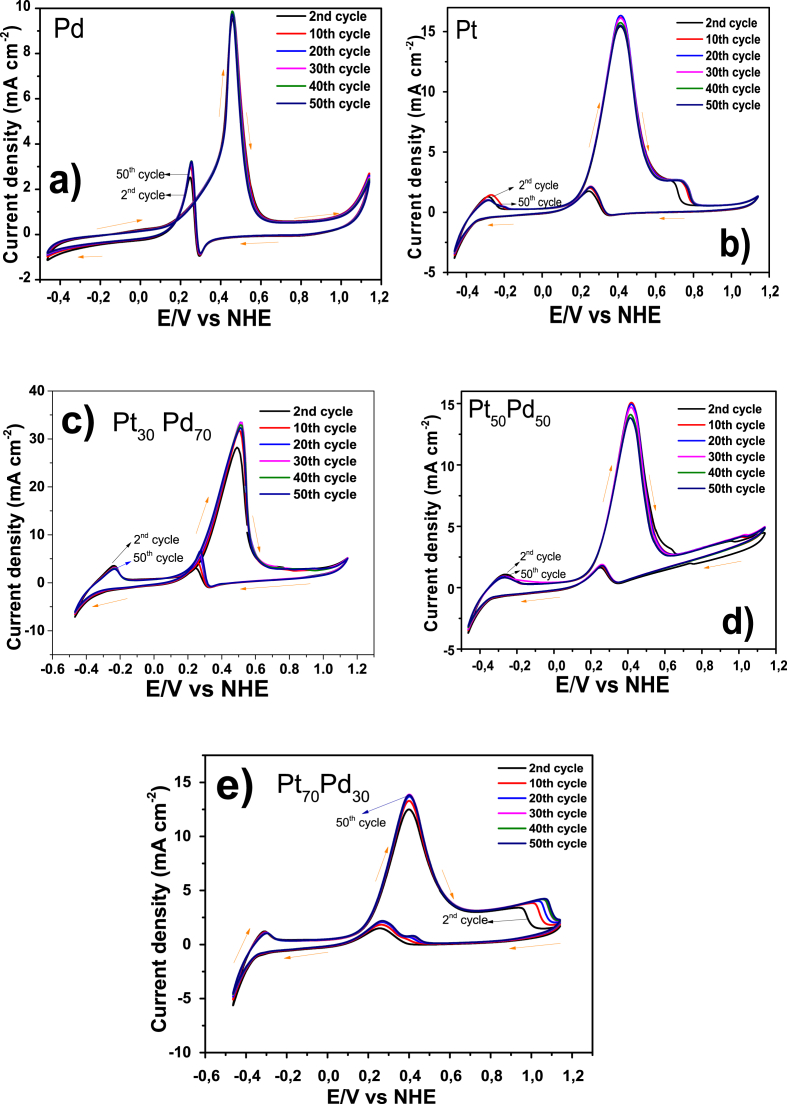
CV diagrams of the supported electrode materials a) Pd, b) Pt, c) Pt30Pd70, d) Pt50Pd50 and e) Pt70Pd30 in 1 M KOH + 1 M CH3OH at 25 °C using a scan rate of 10 mV s−1.